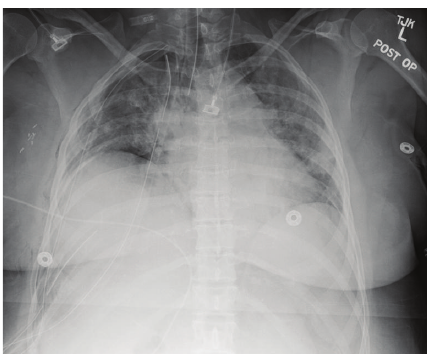
Figure 3: Postoperative day 7 chest X-ray. No evidence of left sided air leak or residual left main bronchus